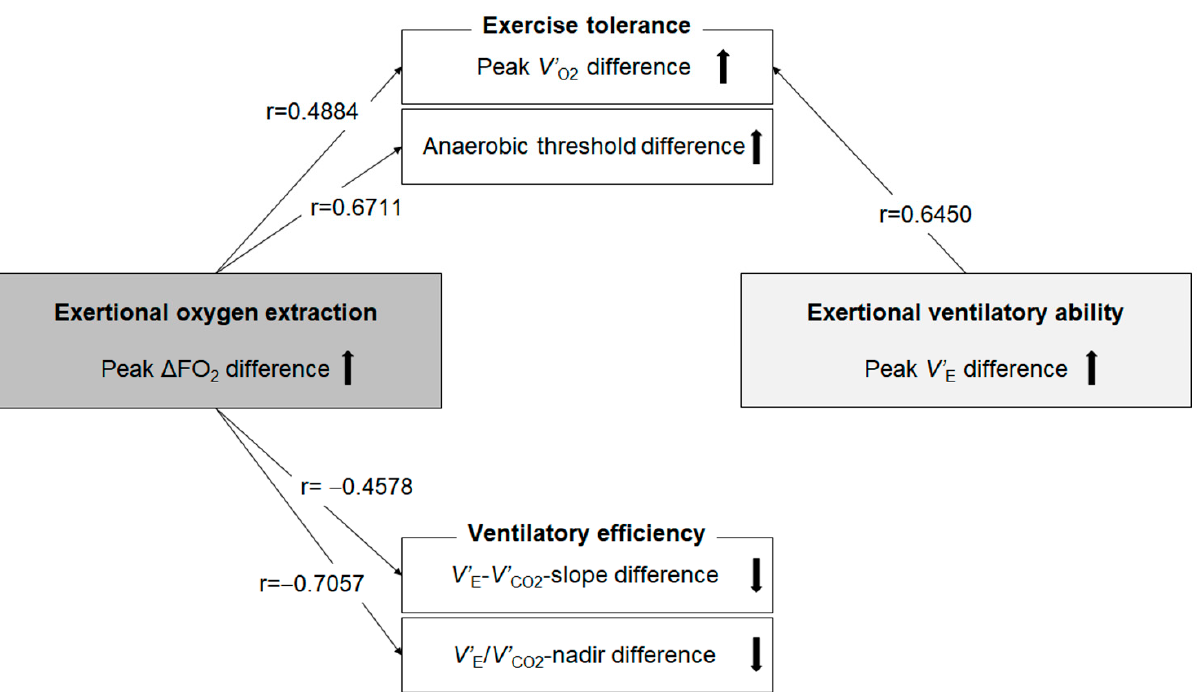
Figure 3. Correlations related to exercise tolerance and ventilatory efficiency. Difference: between before and after pulmonary rehabilitation; ∆ FO 2 : difference between inspired and expired O 2 concentration; V’ E : minute ventilation; V’ E / V’ CO2 -nadir: lowest value of the ratio between minute ventilation and carbon dioxide output during exercise (see the Methods section for details); V’ E – V’ CO2 -slope: the slope was determined by linear regression analysis of minute ventilation to carbon dioxide output observed during exercise (see the Methods section for details); V’ O2: oxygen uptake. Black arrows mean the up and down differences obtained from pulmonary rehabilitation.